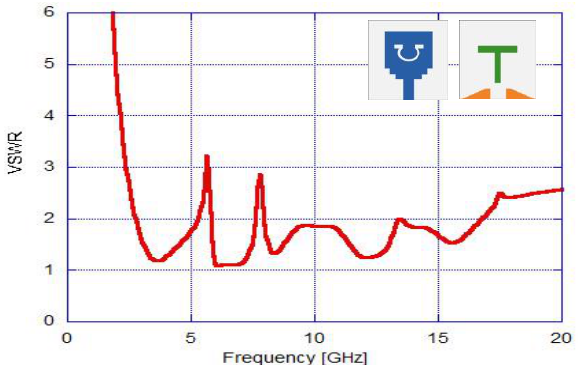
Figure 7: Simulated VSWR for the proposed dual band notched